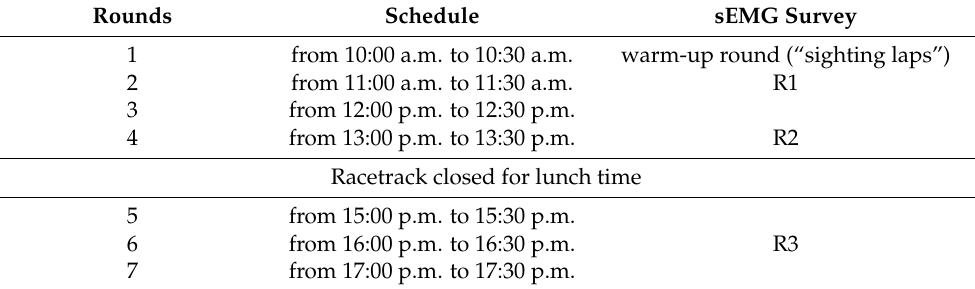
Table 1. Timetable of the track session. Riders of two levels (fast and slow) shared alternatively the access to the racetrack. Our rider followed the schedule of the fast (advanced) group (R1–3). Slow riders began their rounds at all half-past